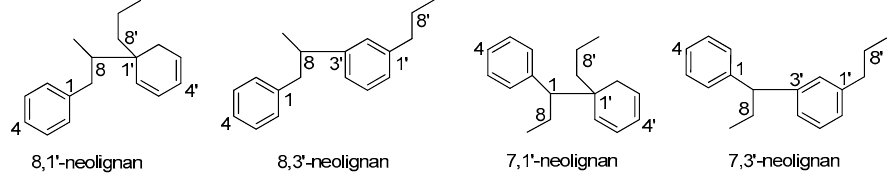
Figure 7. Subtypes of neolignans.